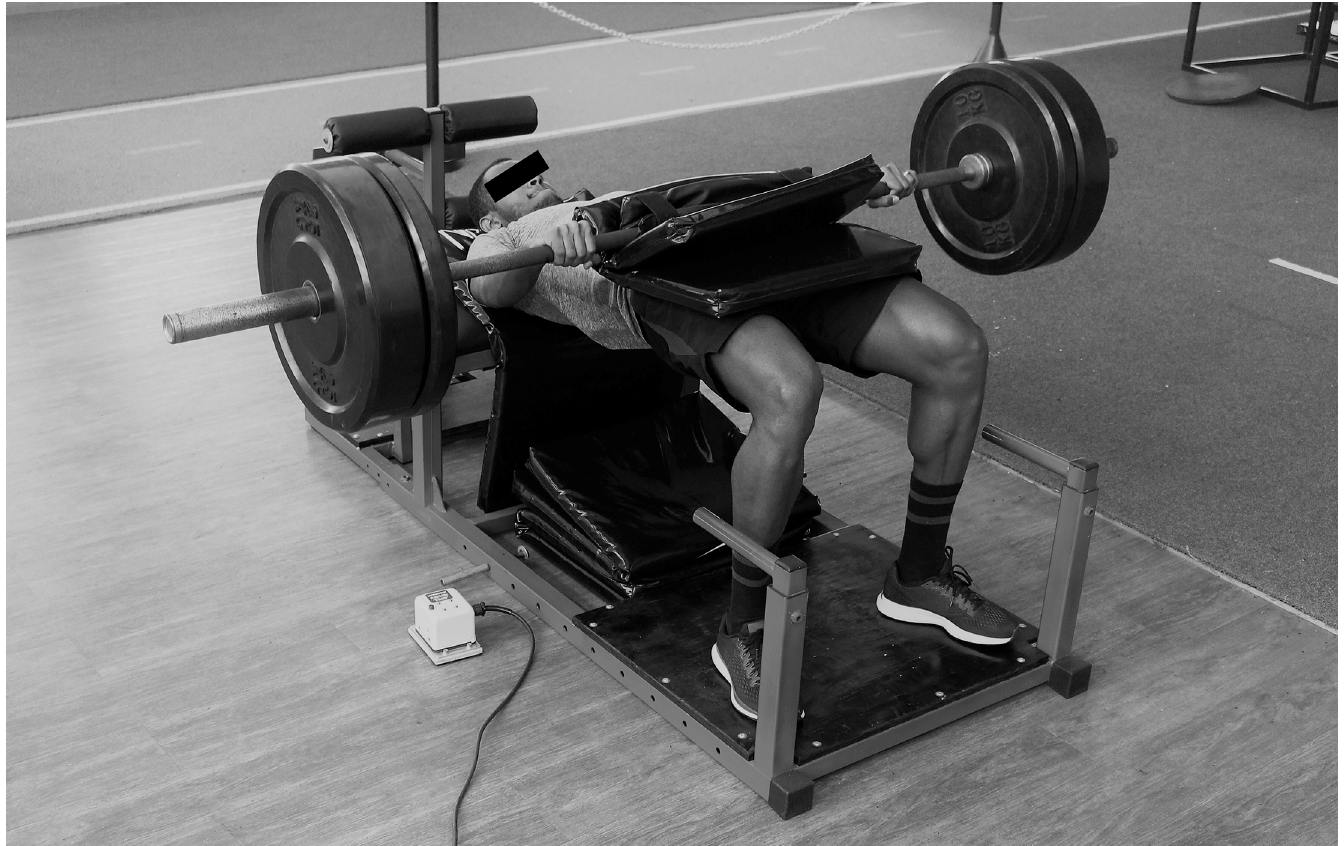
PLOS ONE | https://doi.org/10.1371/journal.pone.0201475 July 26,